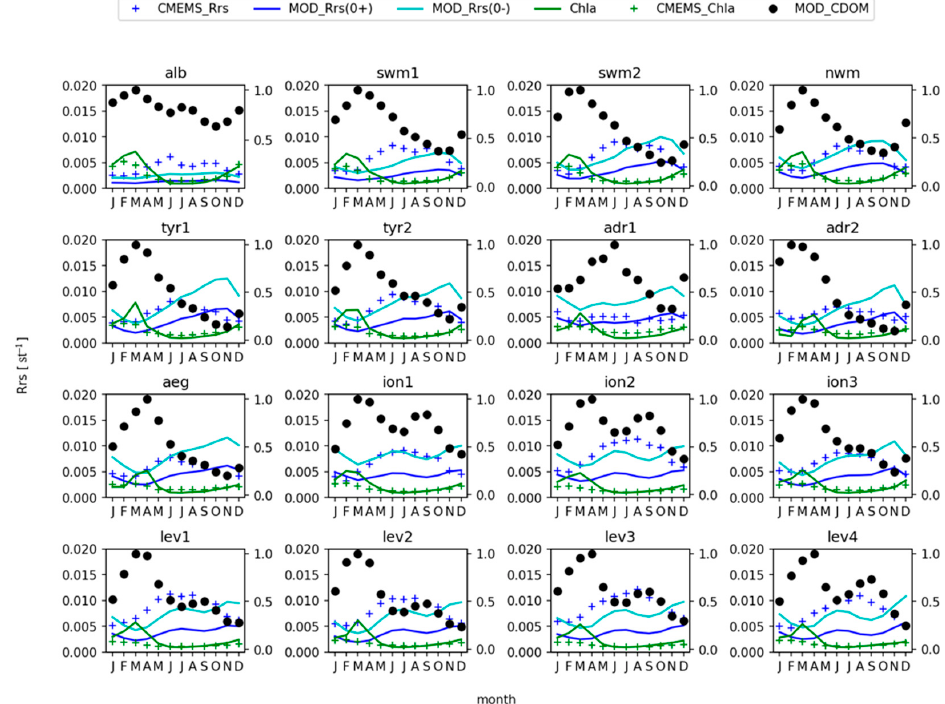
Figure 7. Seasonal variability (year 2017) of remote sensing reflectance (units St − 1 ) at 412 nm: blue crosses [41], thick blue lines (model results from EXP-1 simulation just above the sea surface (0+)) and thick cyan lines (EXP-1 simulation just below the sea surface (0-)). Data and model are averaged over each sub-basin (see Figure 4 for definition). Seasonal variability of the total surface chlorophyll (units mgChl/m3): green crosses (CMEMS product [39]) and green lines (model output) scale is on the left y-axis. Black dots represent the modelled seasonal evolution of total CDOM concentration normalized to one.